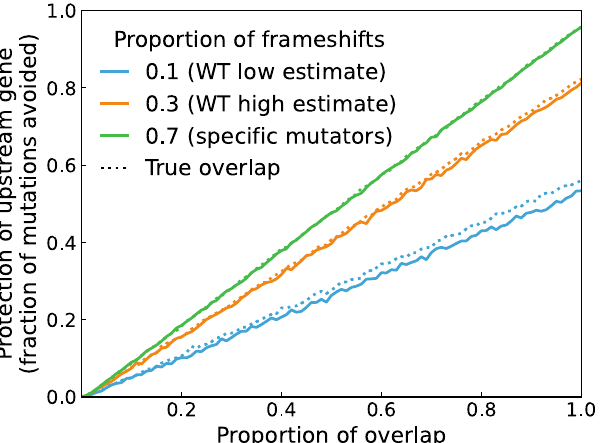
Fig 2. Theoretical protection from mutations conferred by overlapping reading frames. Simulated protection conferred by a gene overlap, depending on the size of the overlap and the fraction of frameshift mutations. The protection is the fraction of loss-of-function mutations in the costly gene that are purged due to the pleiotropic cost induced by the overlap. A true protein overlap (dashed lines) would also protect from non-polar mutations. The average deleteriousness of each amino acid substitutions was P = 0.1 (the effect of other values of P as well as of e e alternative models of protein loss-of-function are shown in S2